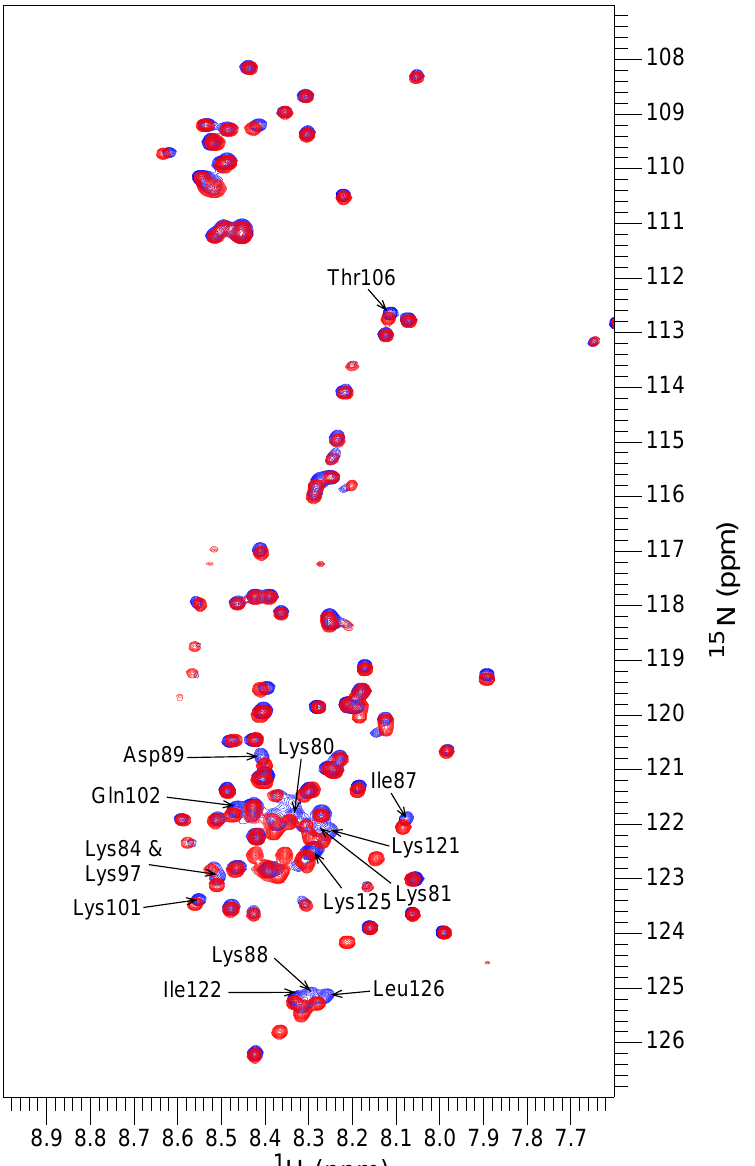
Figure 8. 15 N-HSQC spectra of YSK 2 in the presence and absence of Yfh1. 15 N-HSQC spectra overlap of 0.5 mM 15 N-labelled YSK 2 alone (red) and in the presence of 0.5 mM Yfh1 (blue). All samples are in pH 6.0 phosphate buffer. Data were collected at 300 K.